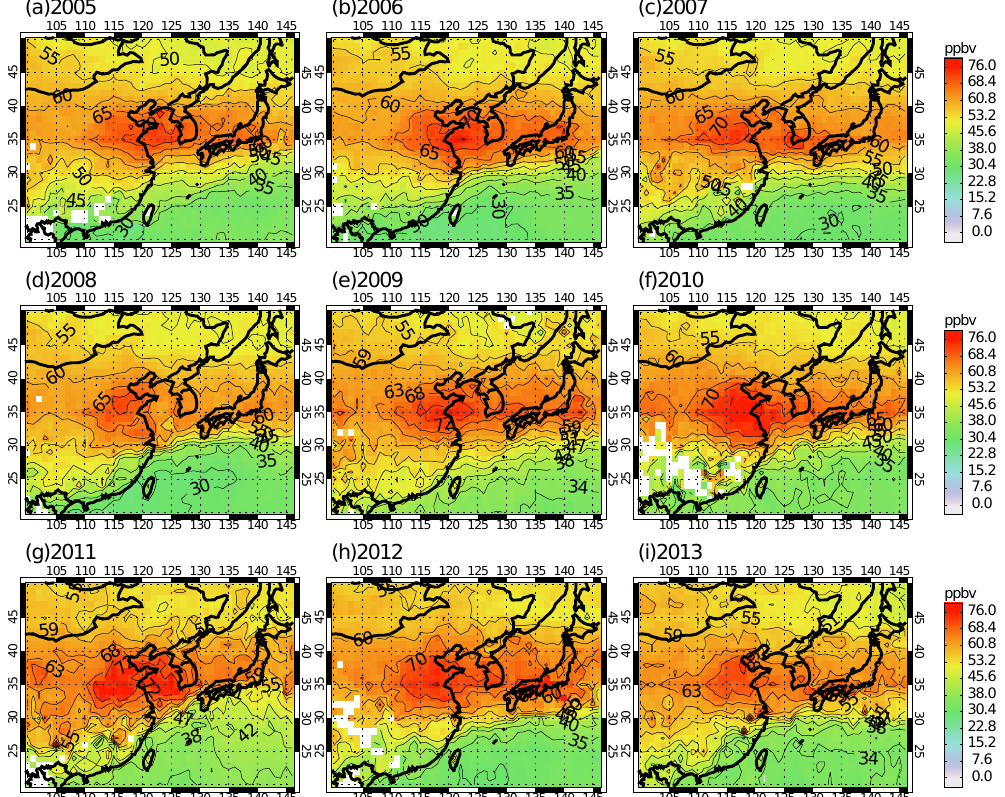
Figure 10. Maps of monthly mean values of retrieved ozone at the 24th layer in June from 2005 to 2013.